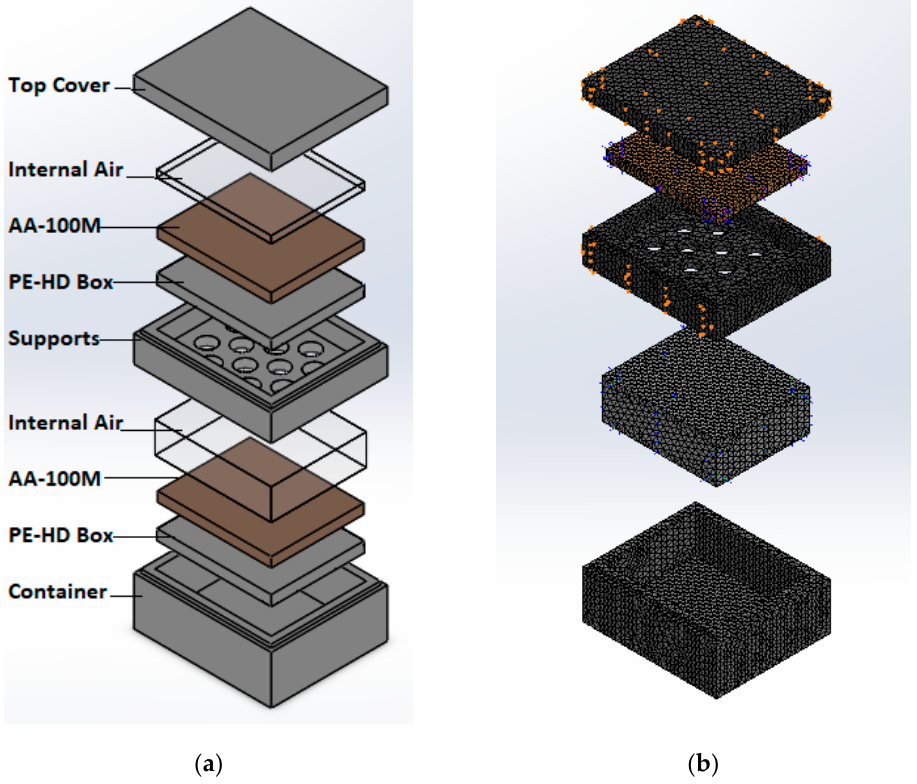
Figure 1. Simulation parameters. ( a ) CAD exploded view of assemble ( b ) Exploded view of the